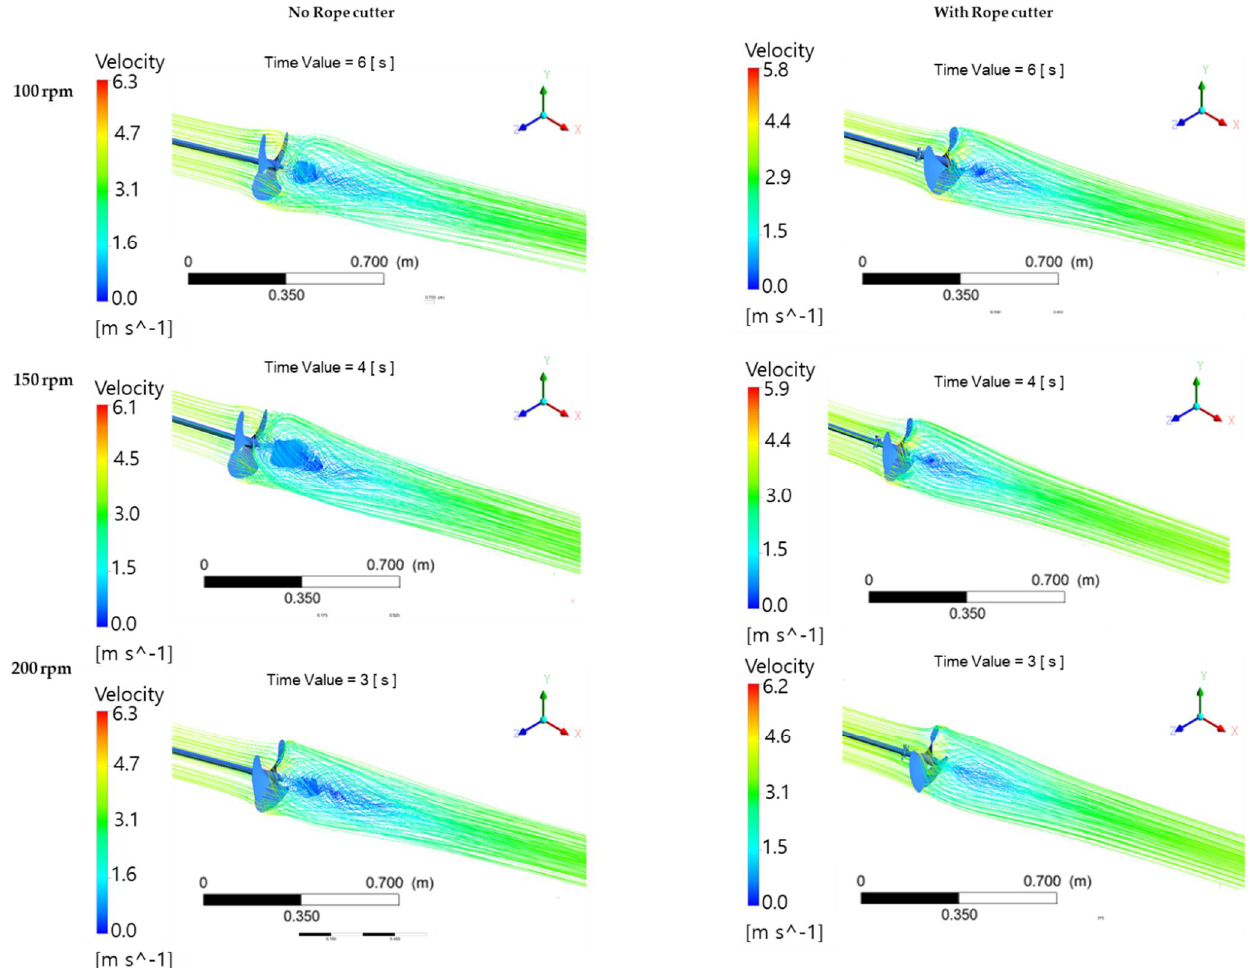
Figure 15. Effects of rope cutter on the velocity streamlines behind the propeller.